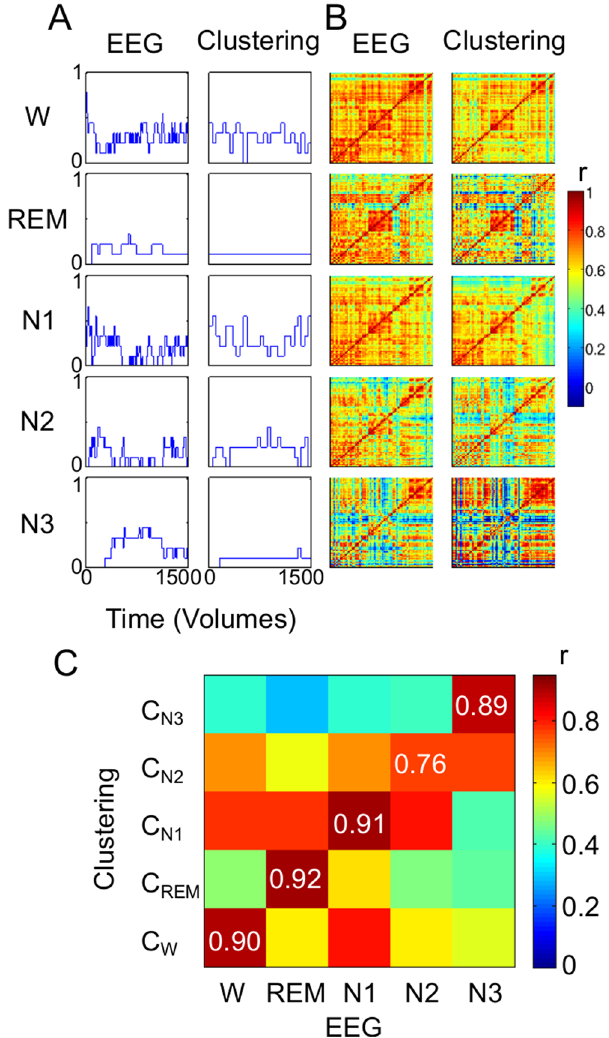
Figure 6. Clustered dynamic connectivity states allow the detection of NREM and REM sleep in a cohort of narcolepsy patients. ( A ) Probability of observing each sleep stage as detected using EEG (left column) and the matched fMRI-based clustered dynamic connectivity state (right column). ( B ) Average correlation matrices for each sleep stage (left column) and for the matched clustered dynamic connectivity states (right column). ( C ) The similarity between the left and right columns in panel B is confirmed by computing the correlation coefficient between the average correlation matrices observed during each sleep stage and those of each dynamic connectivity state (observing the highest values along the